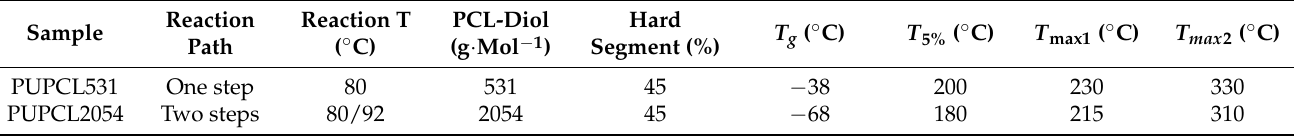
Table 1. Synthesis conditions, DSC and TGA results for PUPCL2054 and